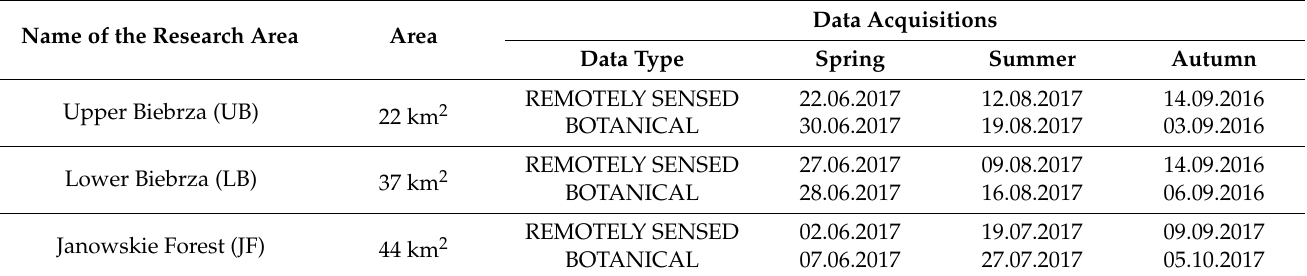
Table 1. Dates of field botanical surveys and flight campaigns.